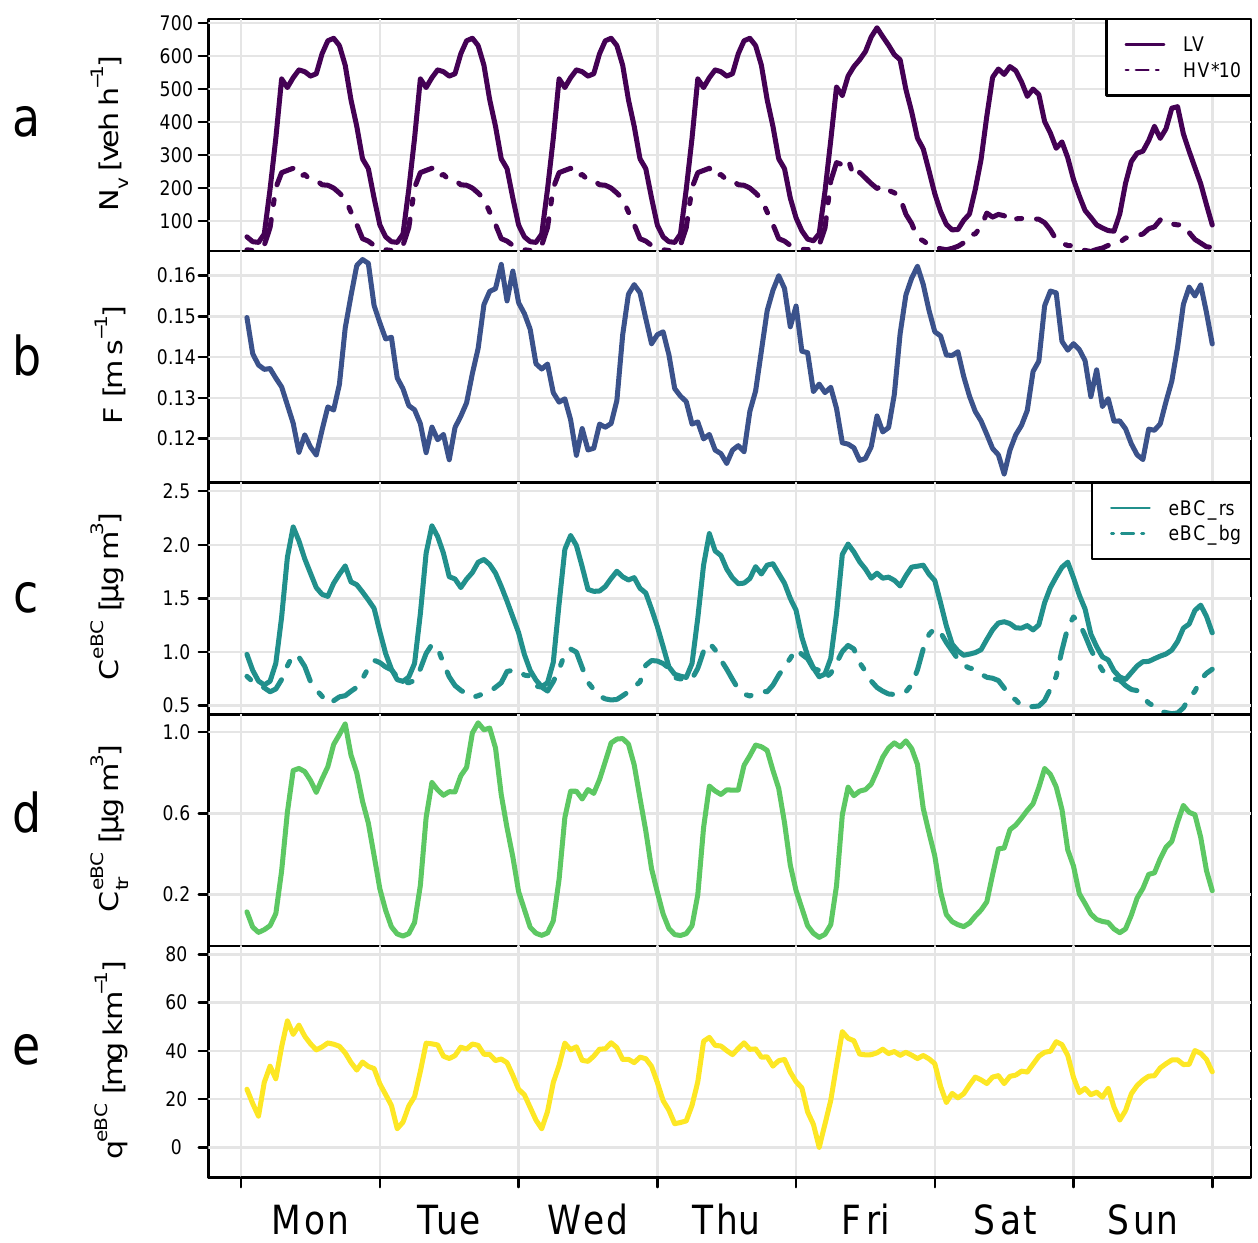
Figure 3. Fixed traffic profile (( a ): light vehicles and heavy vehicles *10, for visibility) and weekly patterns of the median dilution factor F ( b ), black carbon concentration at the background and the roadside stations ( c ), black carbon traffic increment ( d ), and estimated vehicle emission factor for black carbon ( e